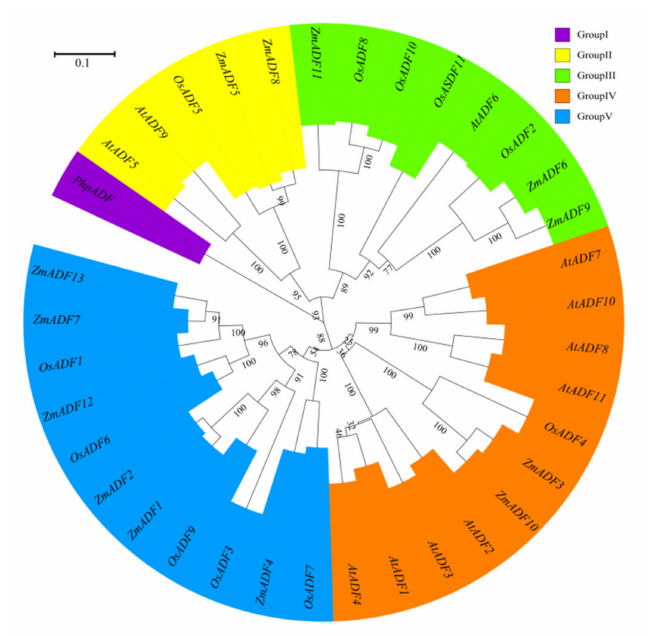
Figure 4. A phylogenetic tree of Arabidopsis , rice, and maize ADF proteins. The maximum likelihood (ML) method using MEGA7.0 software with 1,000 bootstrap replicates was adopted to construct the phylogenetic tree. Di ff erent types are marked with di ff erent